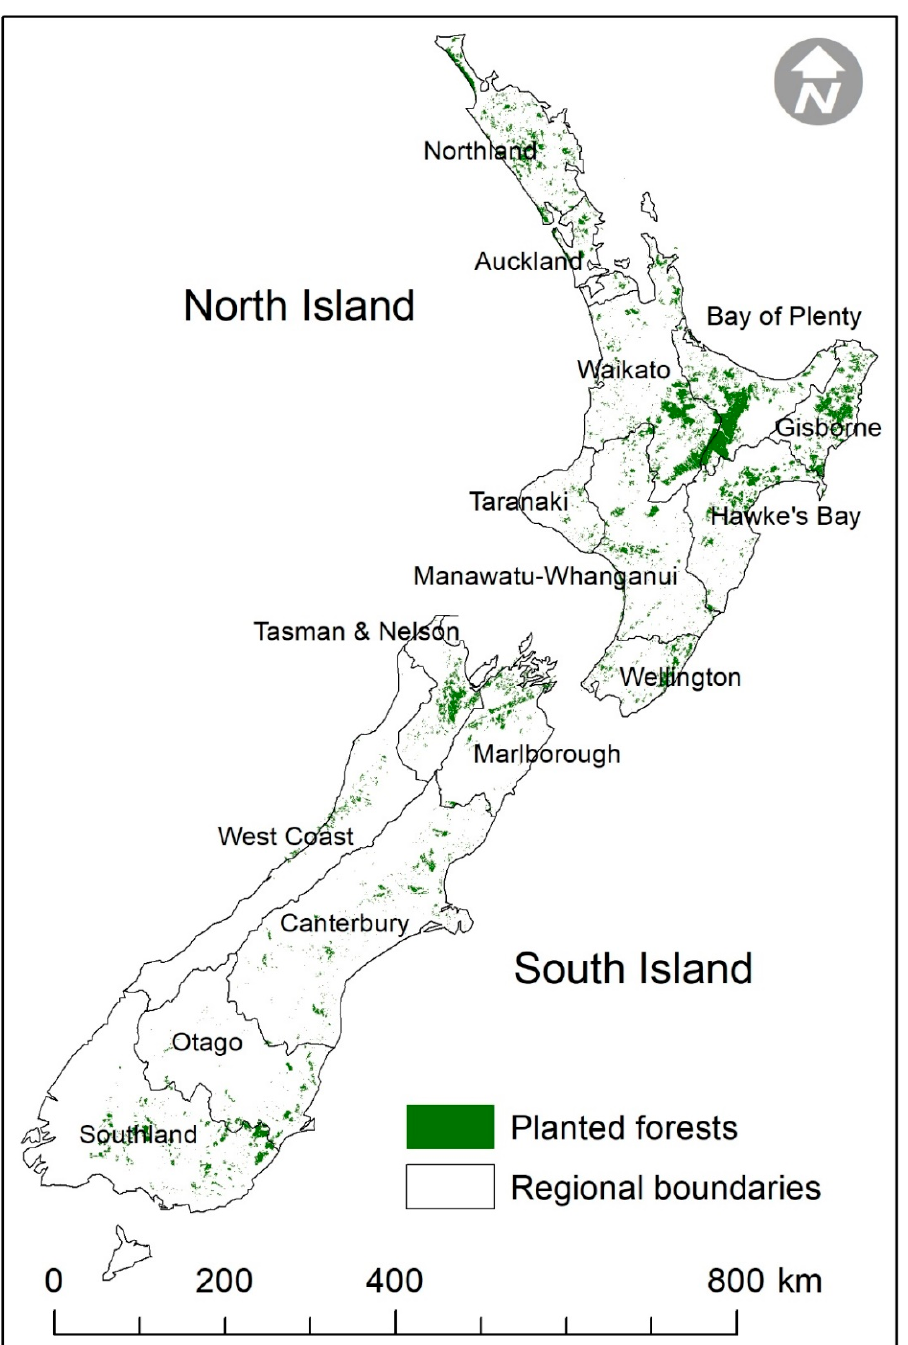
Figure 2. New Zealand planted forest distribution by region using Statistics New Zealand’s regional council boundaries [67].